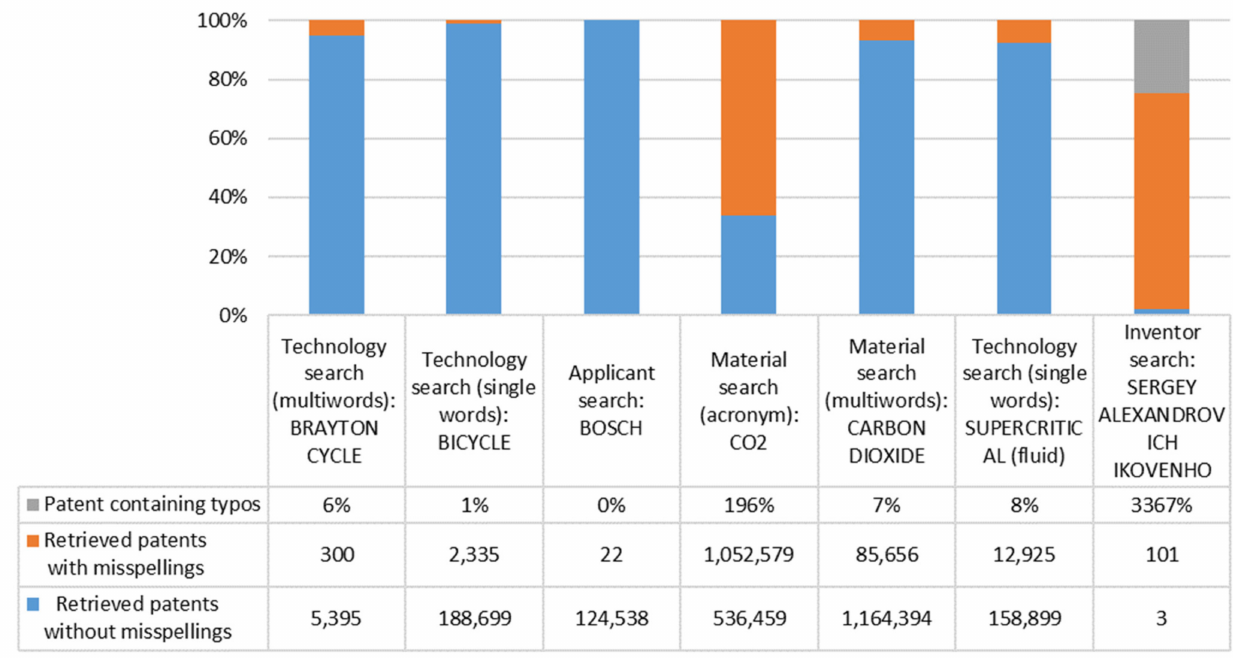
Figure 3. Graphical representation of the retrieved patents with and without misspellings in the considered patent